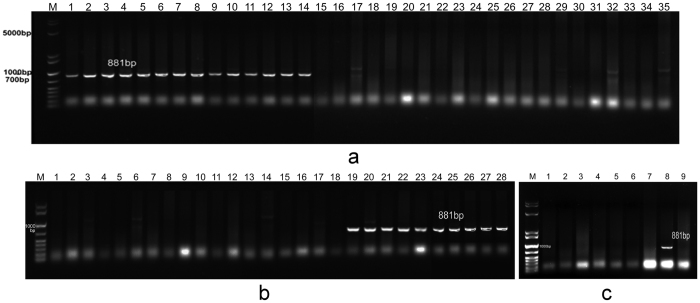
Development and validation of SNP-based molecular marker for Glu-B3h.(a) PCR amplification from different wheat cultivars: 1. CB037B. 2–35 corresponds to 26–59 in Table S4. (b) PCR amplification from RILs from CB037B × Ningchun 4 (1–9, 18–22) and CS-1Sl(1B) × CB037B (10–17, 23–27). 28. CB037B. (c) PCR amplification from Aroona NILs. 1. Aril20-1, 2. Aril21-2. 3. Aril23-4. 4. Aril24-3. 5. Aril26-1. 6. Aril27-6. 7. Aril29-4. 8. Aril28-4. 9. Aril30-1. M is marker (10 kb, 8 kb, 5 kb, 2 kb, 1.6 kb, 1 kb, 700 bp, 500 bp, 400 bp, 300 bp, 200 bp, 100 bp).